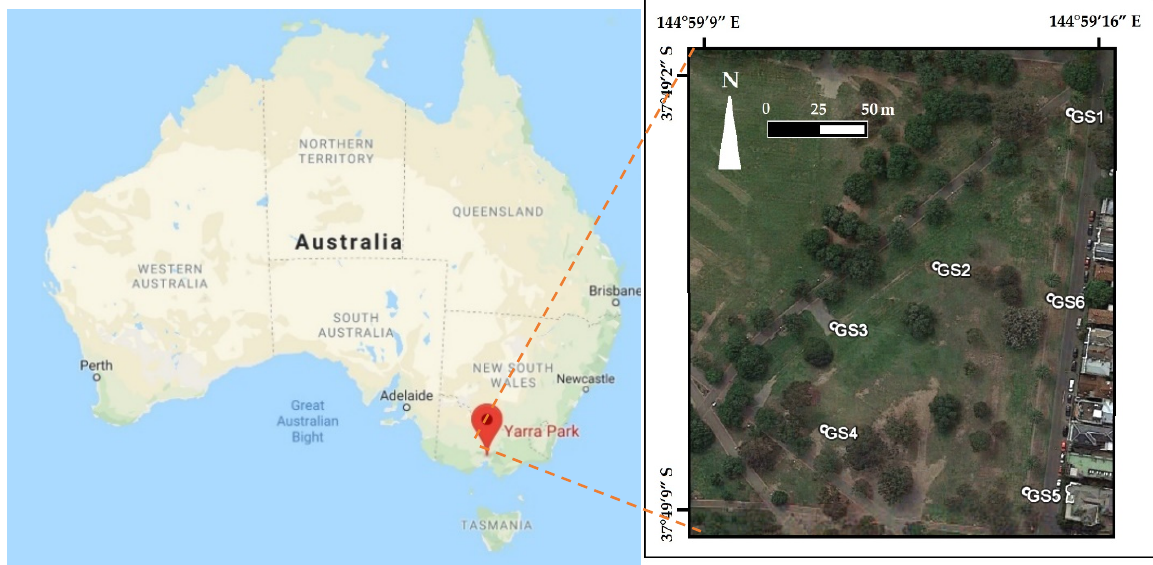
Figure 1. Study area partially comprising Yarra Park, Melbourne and measured GCPs.